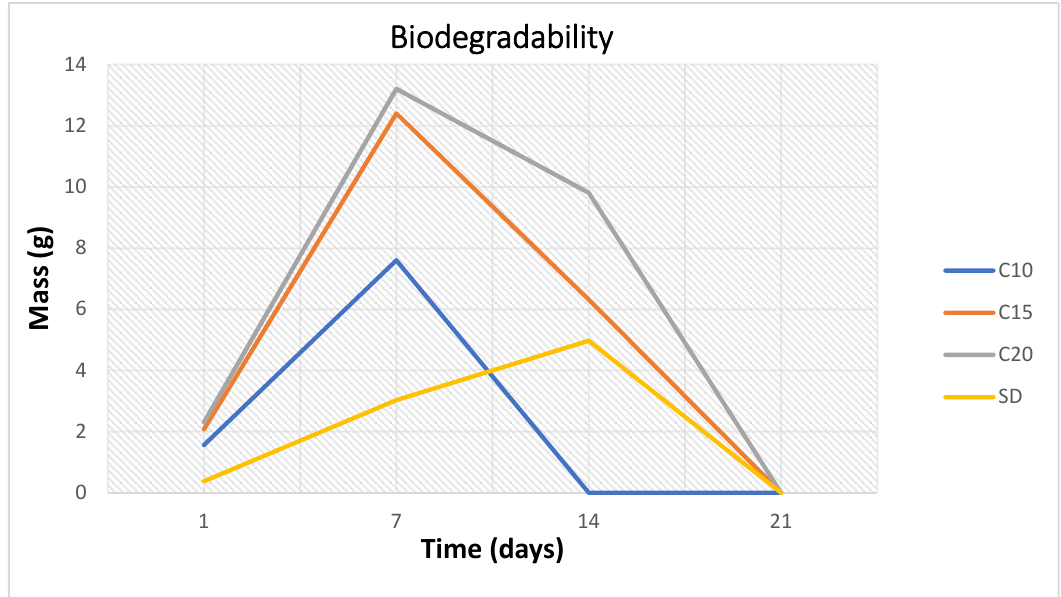
Figure 2. Biodegradation timeline of foams developed from the potato by-products that were buried in black soil.